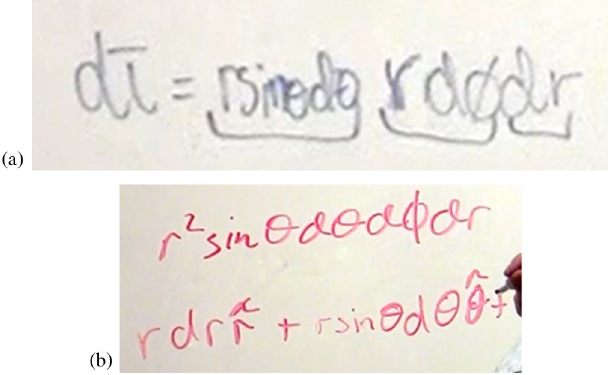
FIG. 3. (a) Incorrectly distributed length terms in a spherical differential volume written by Carol and Dan. (b) Unsuccessful attempt to reconstruct differential spherical length element by Greg and